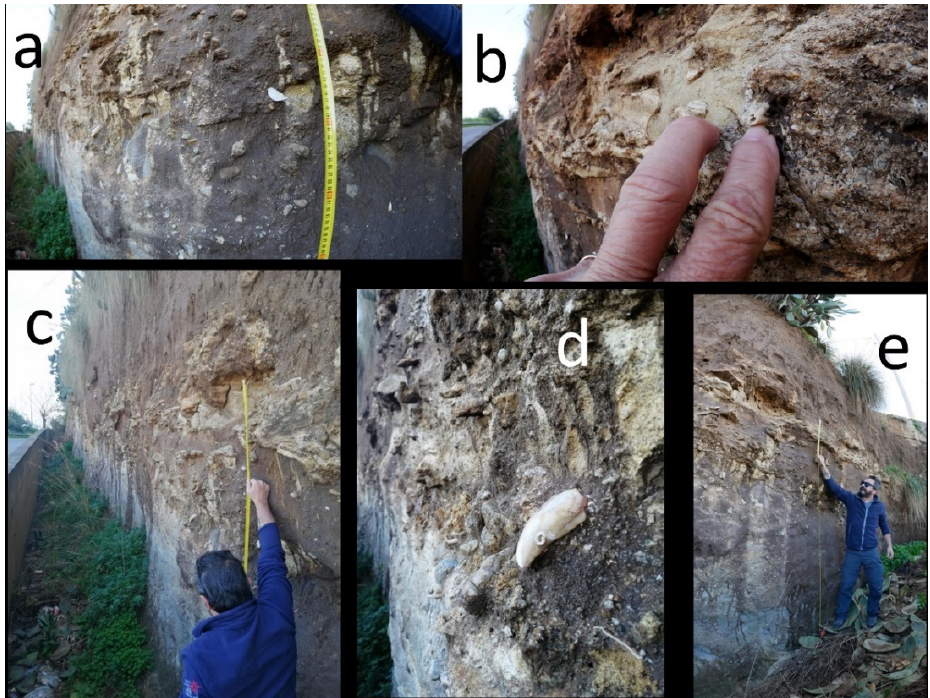
Figure 6. The Cannitello 1 outcrop. ( a , b , c , e ) The size and some details of the section. ( d ) The radiocarbon aged (sample LTL20153A of Table 2) Mytilus in situ. radiocarbon aged (sample LTL20153A of Table 2) Mytilus in